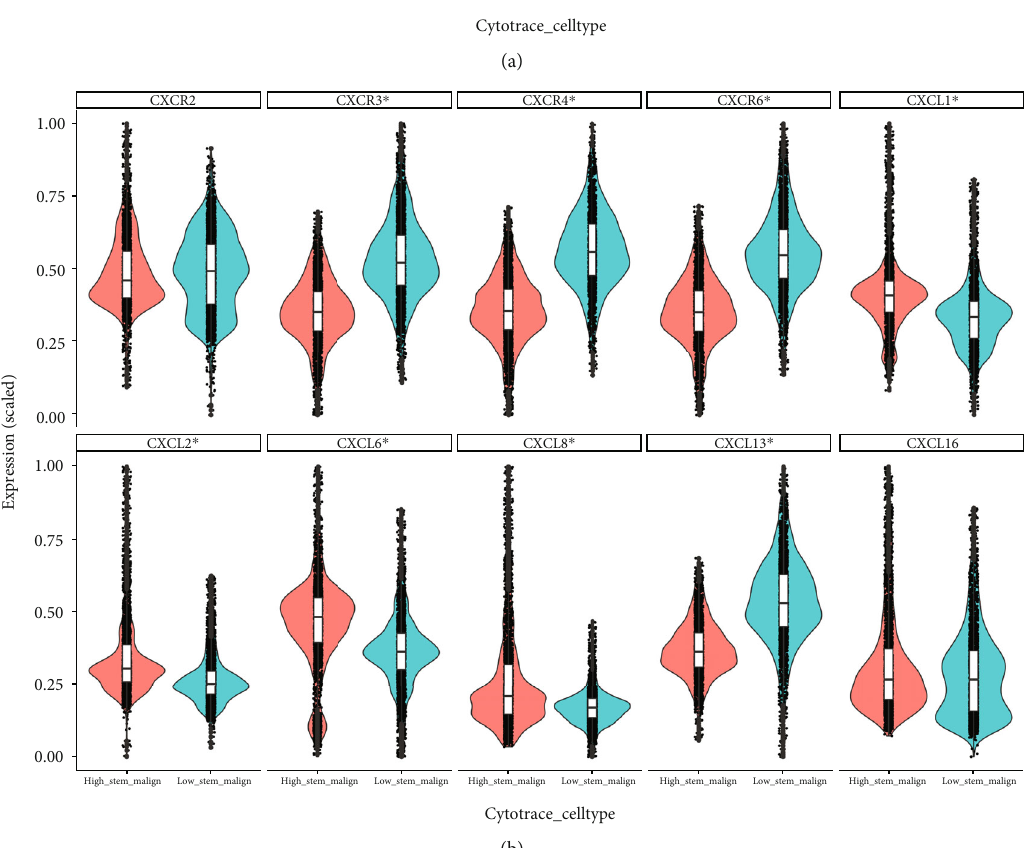
Figure 4: Comparison of C-C and C-X-C cytokine pro fi le between high stemness and low stemness iCCA cells. (a) Violin plot of C-C chemokines. (b) Violin plot of C-X-C chemokines. ∗ indicates P < 0 : 05